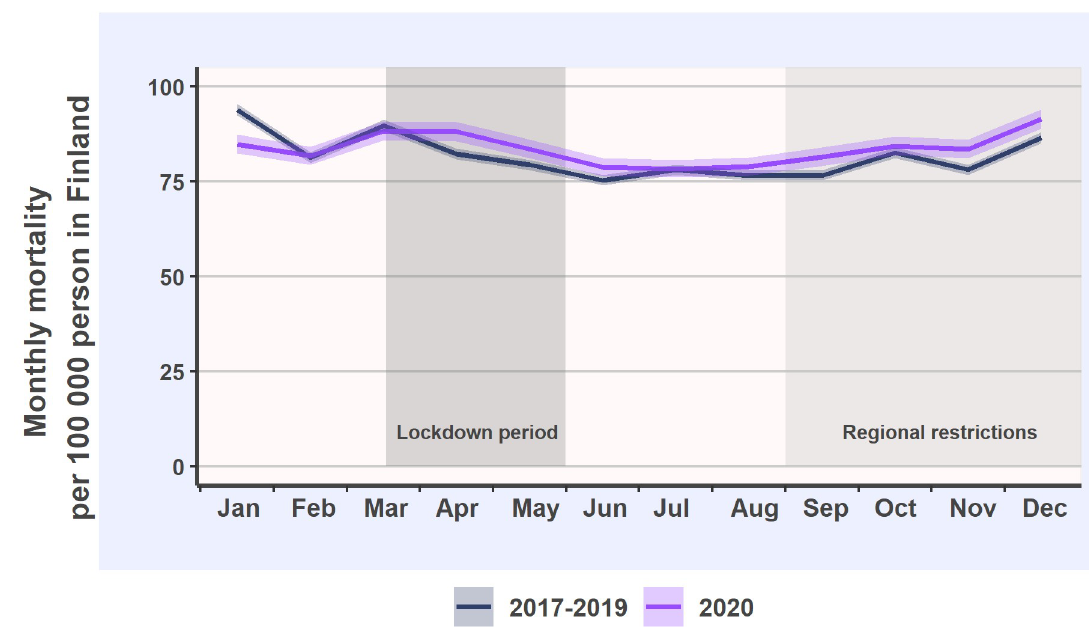
Fig 4. Monthly national mortality incidence per 100 000 persons in Finland and 95% confidence intervals in 2020 (purple line) and in the reference years (black line). Statistics Finland Population data, available in [https://pxnet2.stat.fi/PXWeb/pxweb/fi/StatFin/].